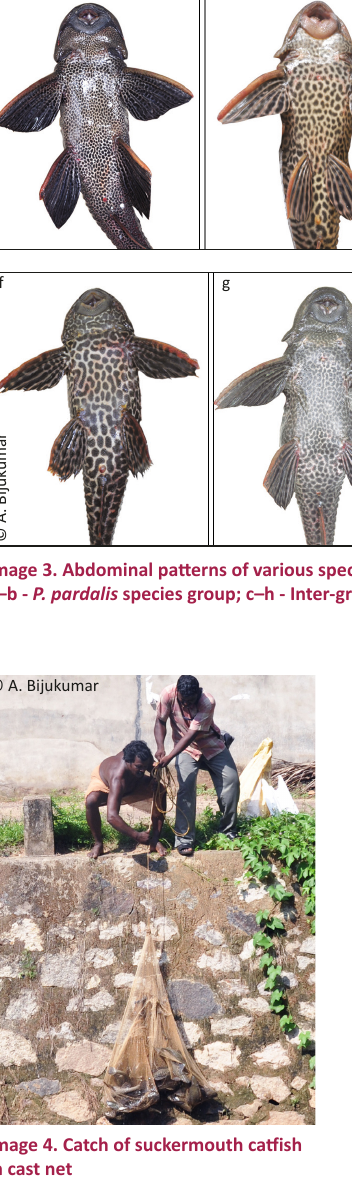
P. pardalis possessed a radiating pattern of light lines on the head. Absence of specific taxonomic characters